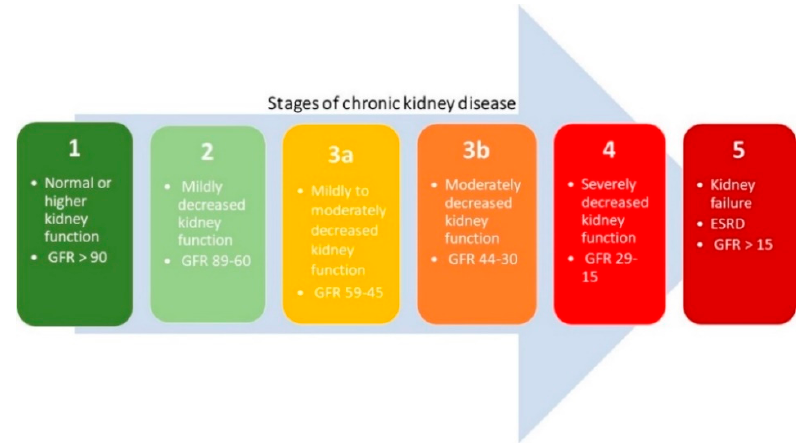
Figure 1. Five stages of chronic kidney disease based on the estimated glomerular filtration rate (eGFR) (mL/min per 1.73 m²).